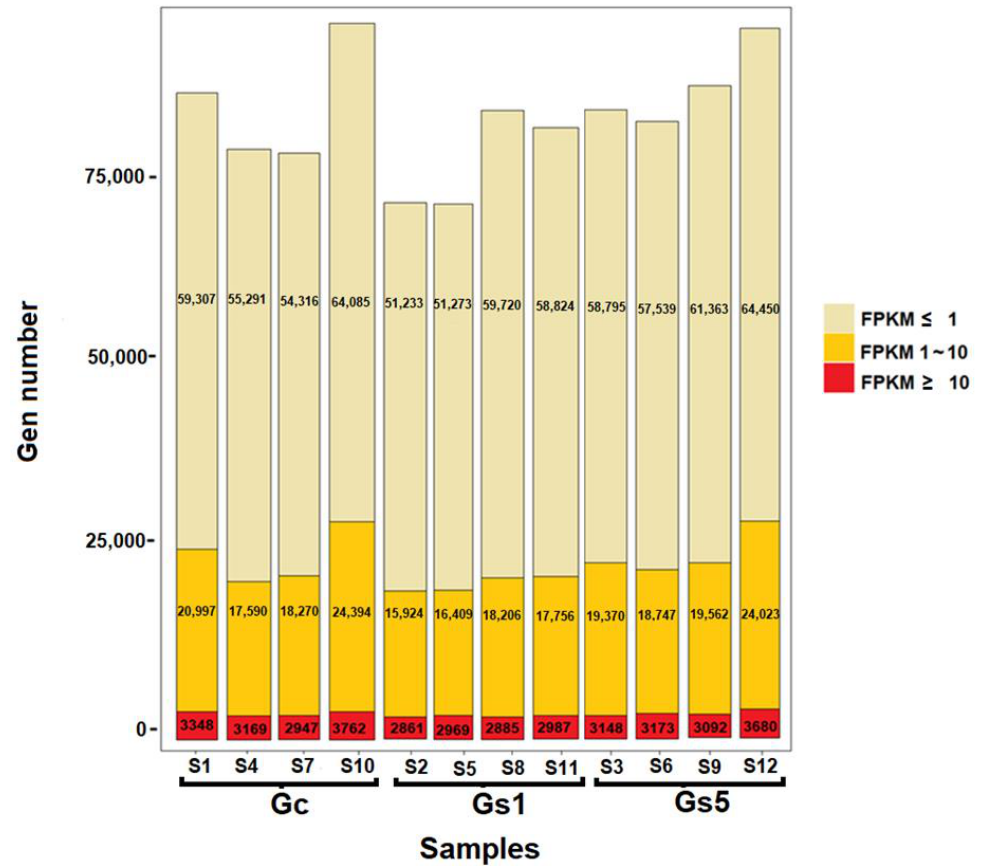
Figure 3. Quantification of transcripts of the loggerhead turtle, Caretta caretta , for each of the samples evaluated according to their high (FPKM > 10), medium (FPKM between 1–10), and low (FPKM < 1) abundance.